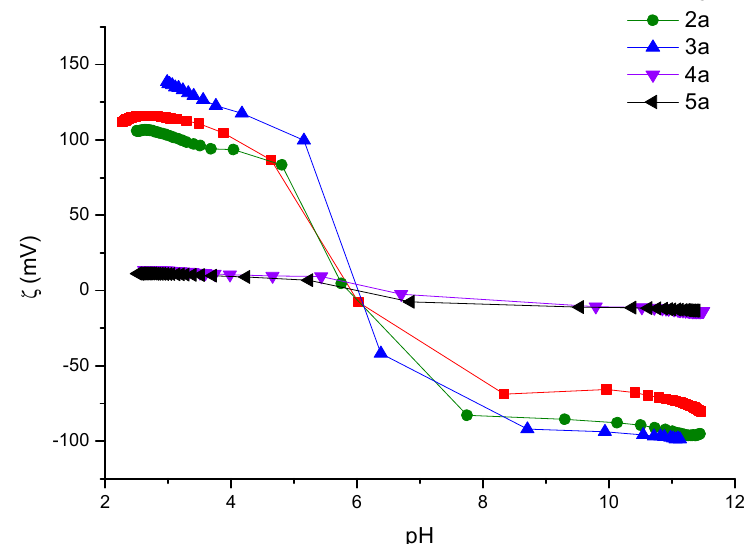
Figure 4. Profiles the ζ = f (pH) of BOAB compounds in water, concentration is 1 × 10 − 5 M.